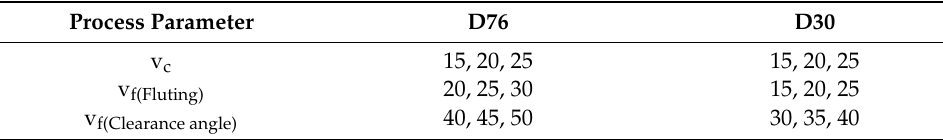
Table 1. Process Parameter during the grinding of end mills.